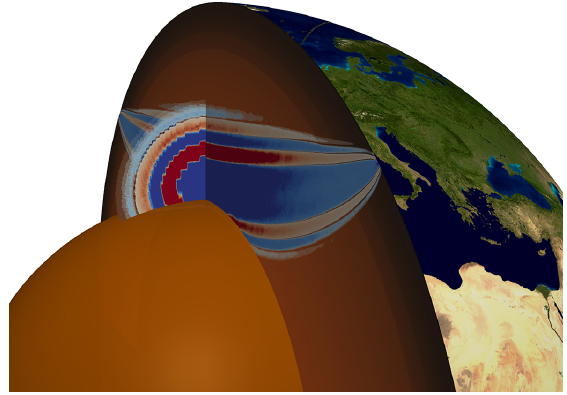
Figure 17. A sensitivity kernel computed with wavefields from AxiSEM, time-integrated (time window: 20s) over the arrival of the direct P wave at 90 ◦ distance for a dominant period of 10s. This denotes the “region of influence” in which this particular time window in the seismogram may “see” the compressional structure that deviates from the background model. Such kernels are not only the basis for waveform tomography, but may also aid in identifying obscure arrivals in the